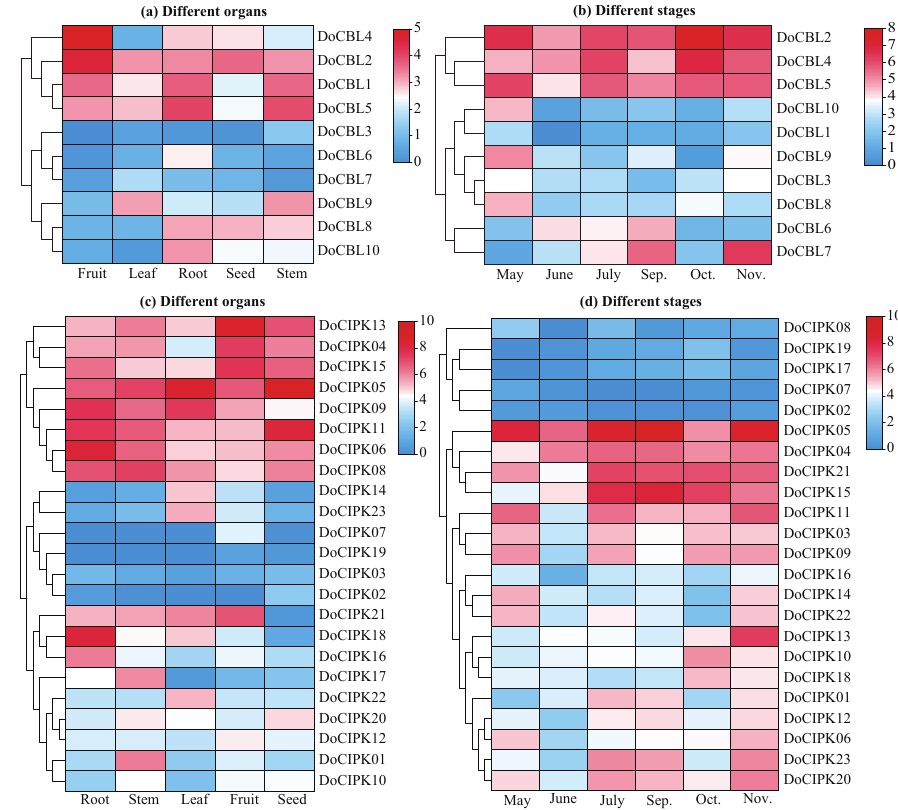
Figure 6. Expression levels of DoCBL and DoCIPK genes in different oil persimmon tissues ( a , c ) and at different stages of oil persimmon fruit development ( b , d ), values = Log 2 (FPKM +